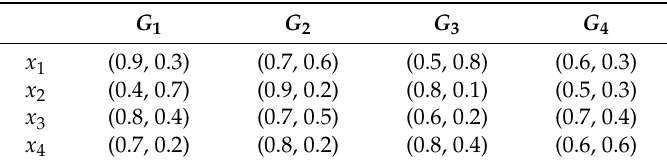
Table 1. The Pythagorean fuzzy decision